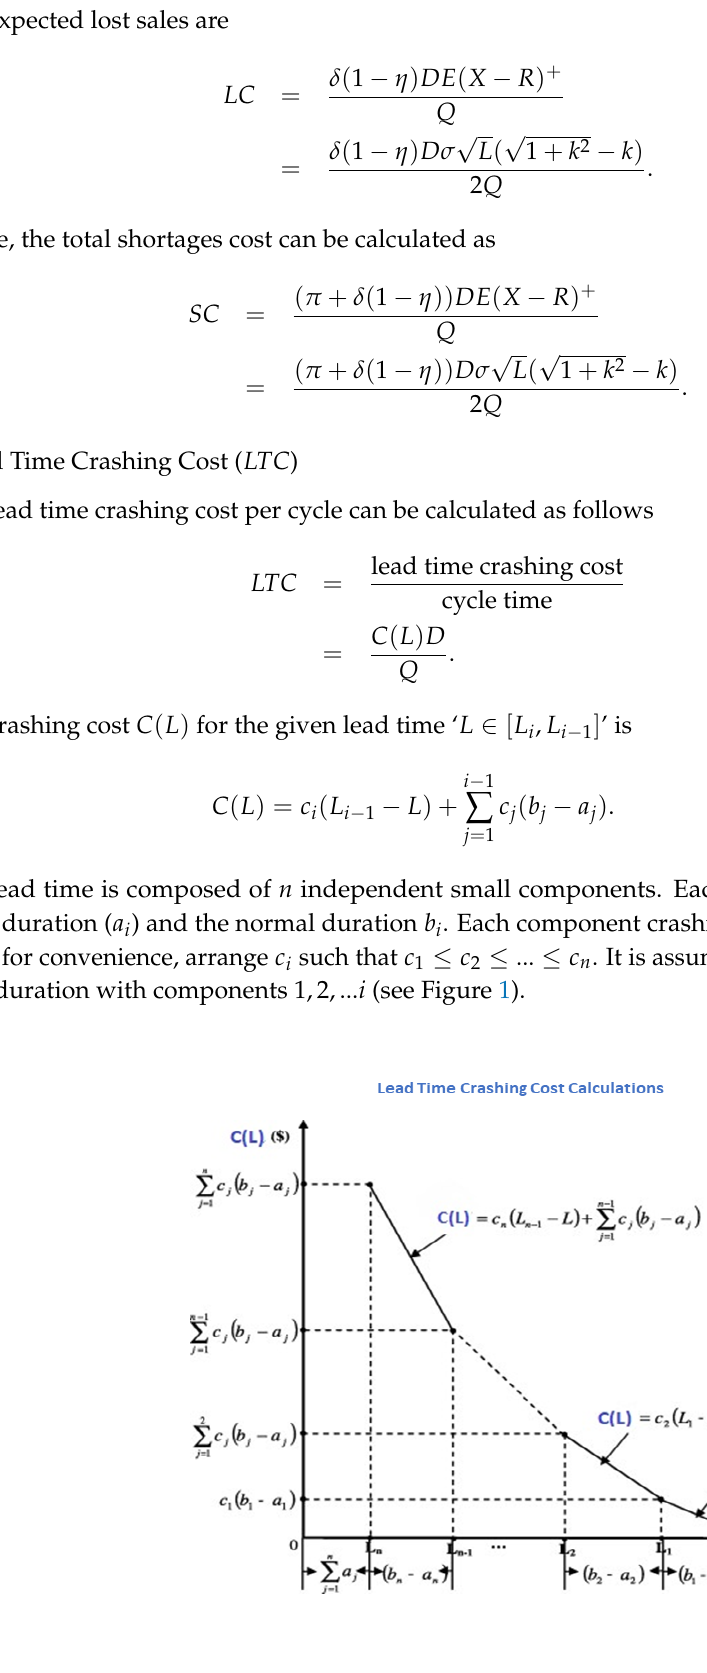
Figure 1. Lead time crashing cost